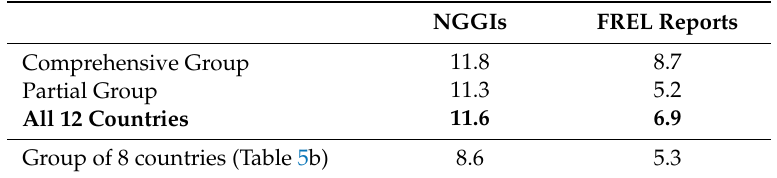
Table 7. Mean Uncertainty Scores for the National Greenhouse Gas Inventories (NGGIs) and Forest Reference Emission Level (FREL) reports of the comprehensive and partial groups of countries, and the group of 8 countries in Table 5b